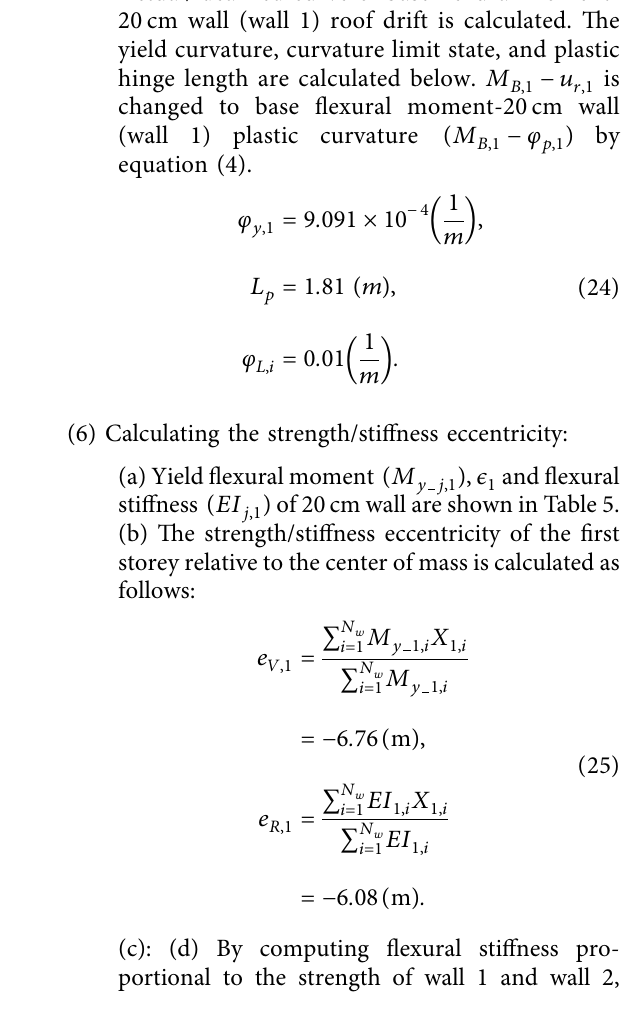
Figure 8: First-mode SDOF system: (a) frst-mode base shear-reference point displacement curve ( V curve of the corresponding SDOF system (( F s,